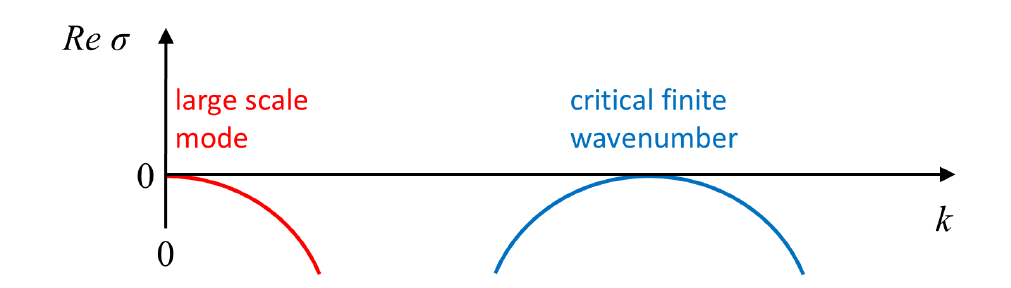
Figure 2. Schematic representation of a dispersion relation obtained from infinitesimal periodic perturbations, proportional to exp ( σ t + ikx ) , about a uniform steady state; Re [ σ ] is the perturbation growth rate and k its wavenumber. The right-hand part of the dispersion relation represents the onset of an instability of a finite wavenumber type (often also referred to as Turing instability), while the left-hand part reflects a conserved quantity and stays always neutral; both parts are model-independent. The curves may connect as typically occurs in systems such as (1) or belong to different curves, such as for (5). The imaginary part of σ corresponds to stationary nonuniform patterns if zero, and otherwise describes time-dependent